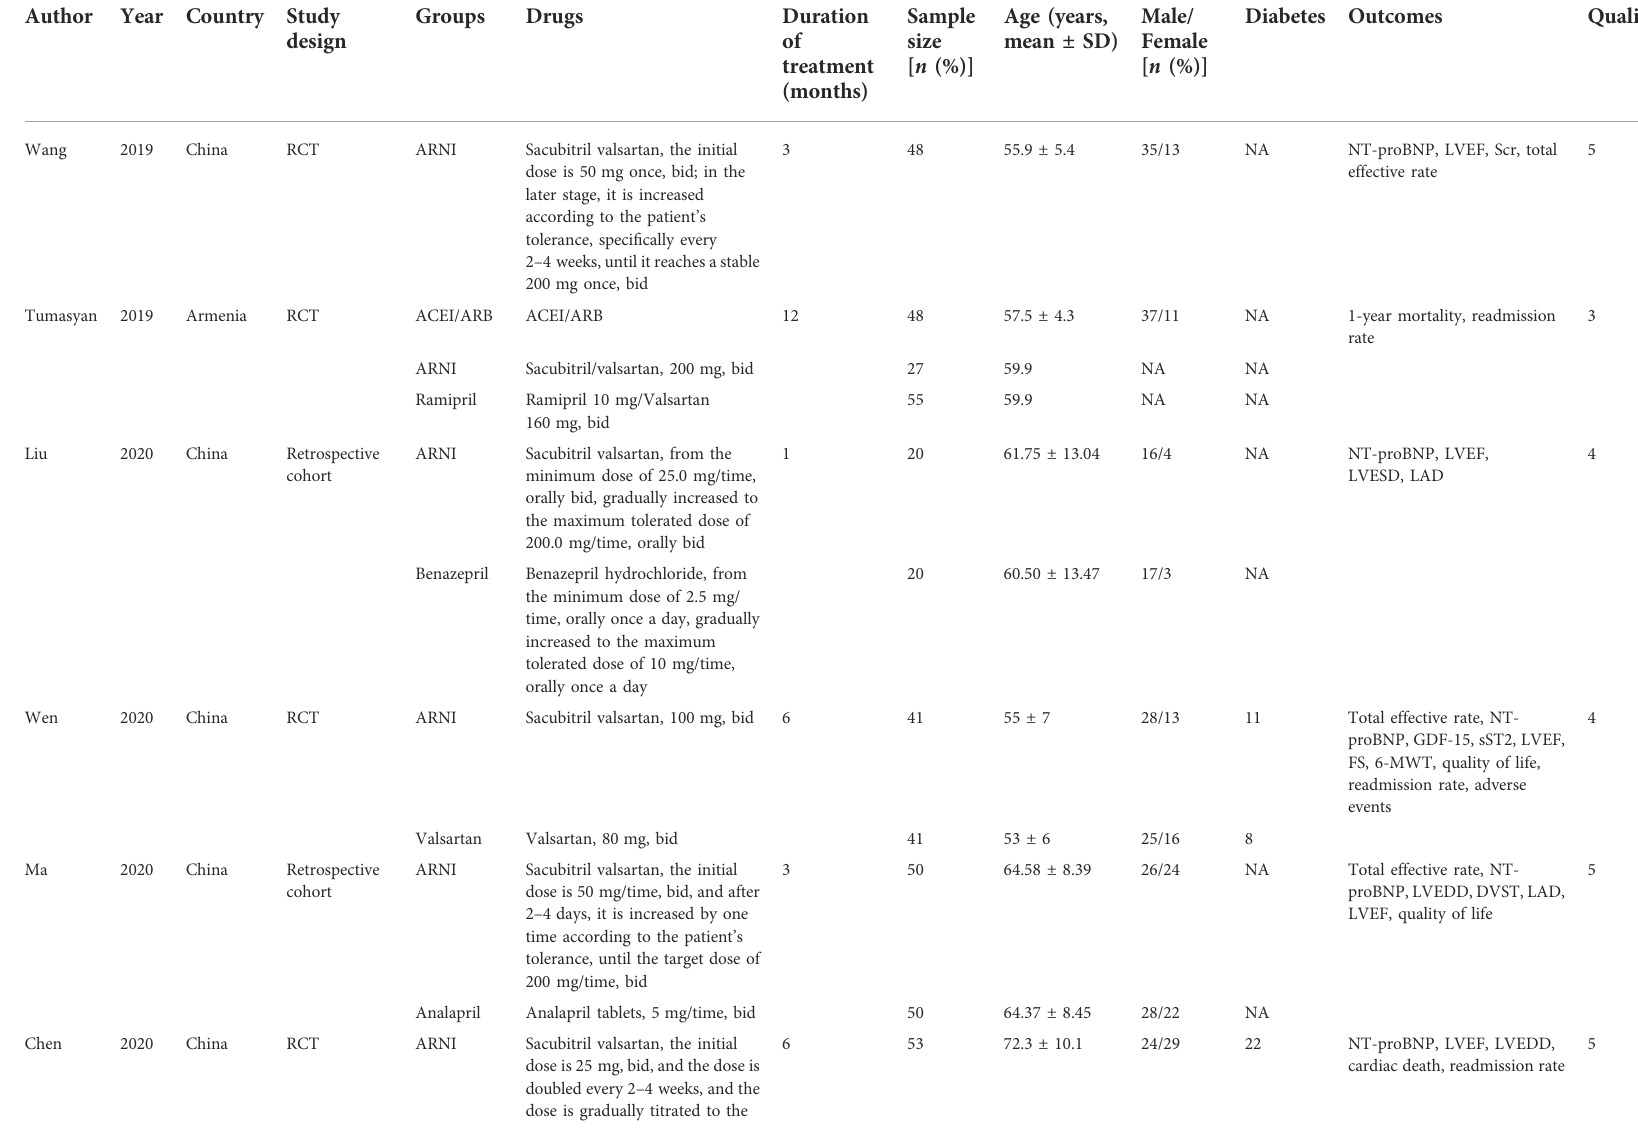
TABLE 1 Basic characteristics of included